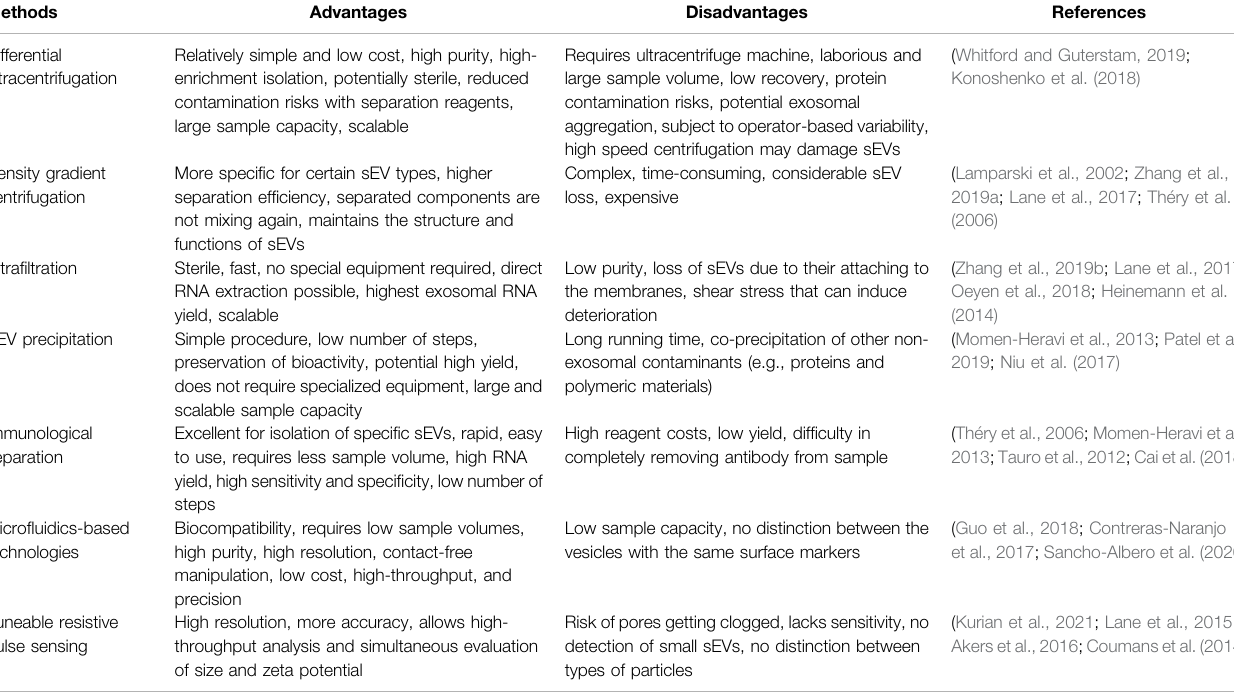
TABLE 1 | Advantages and disadvantages of most used methods to isolate small extracellular vesicles